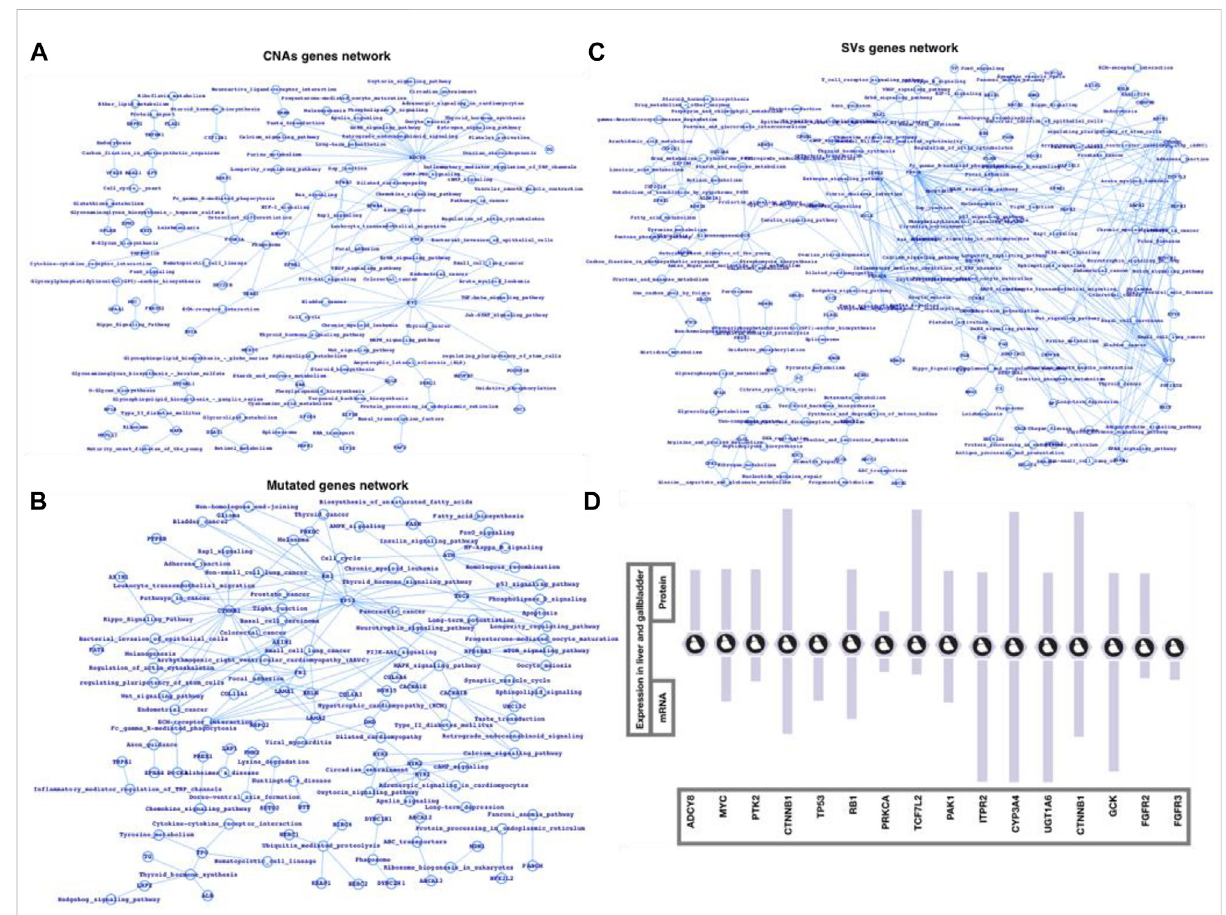
FIGURE 4 Network-levelunderstandingtop-rankedgenesandtheassociatedpathways. (A) CNAgenesnetwork, (B) Mutatedgenes, (C) SVgenesnetwork followed by their respective analysis, and (D) mRNA and protein expression in liver and gallbladder tissues (source protein